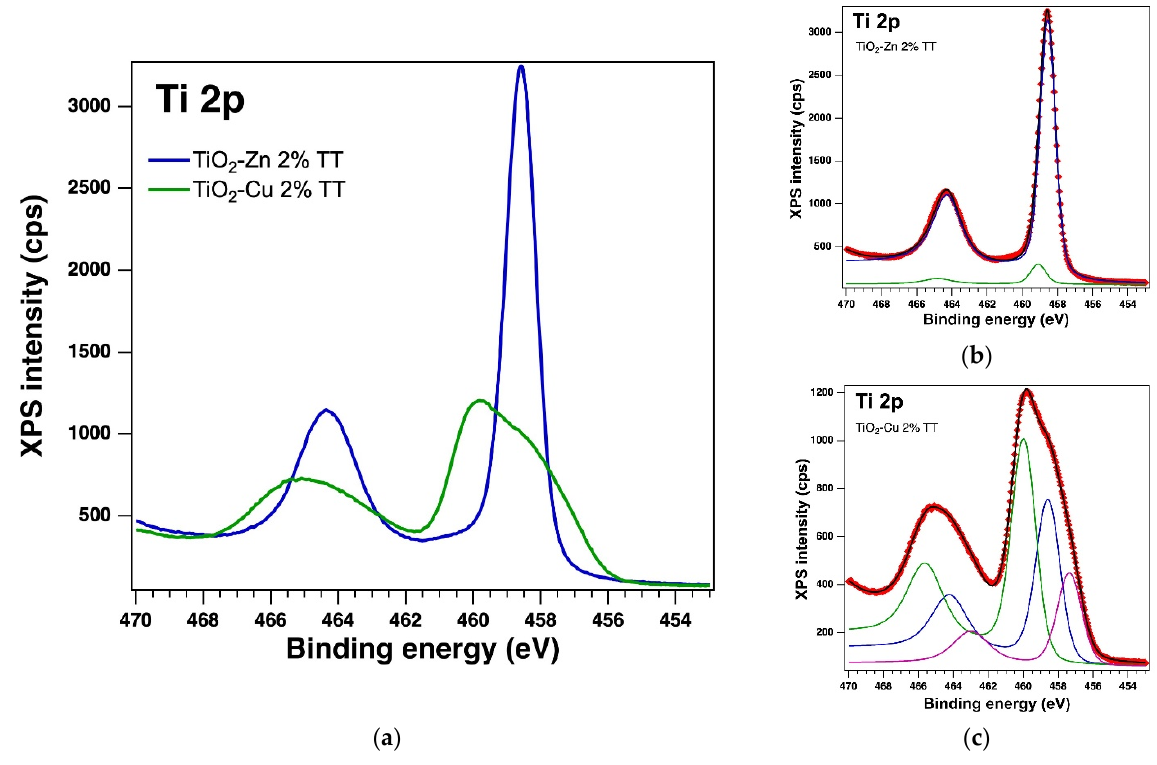
Figure 10. XPS spectra of the core level Ti 2p ( a ) overlayed XPS spectra of the thermally treated samples and the experimental data (red symbols) with the fit and deconvolutions for ( b ) the sample with Zn (deconvolutions: components C1 – blue line and C2–green line) and ( c ) the sample with Cu (deconvolutions: components C1–blue line, C2–green line and C3–magenta line). Table 4. Binding energies, at. % and interpretation of the components of the core levels of interest for the thermally treated samples.